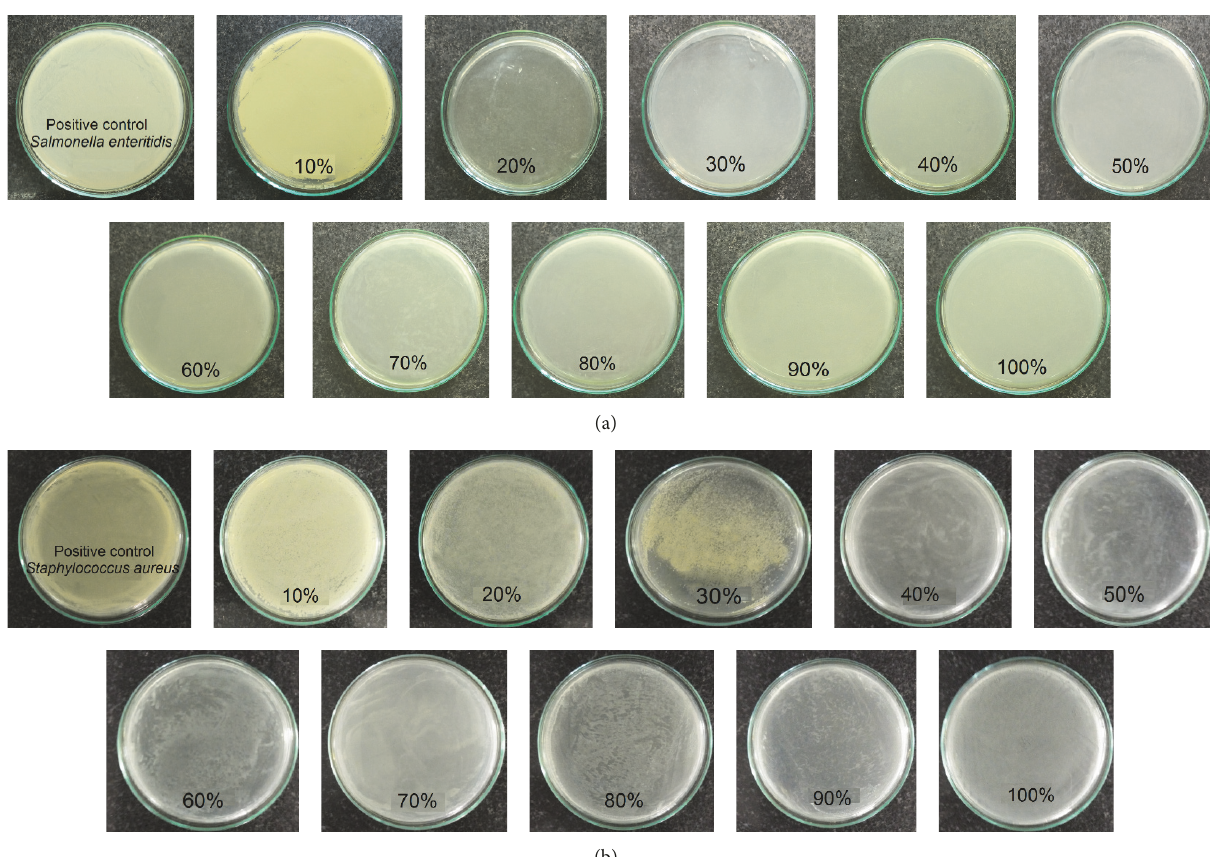
Figure 5: MIC of FFAs against Salmonella enteritidis (a) and Staphylococcus aureus